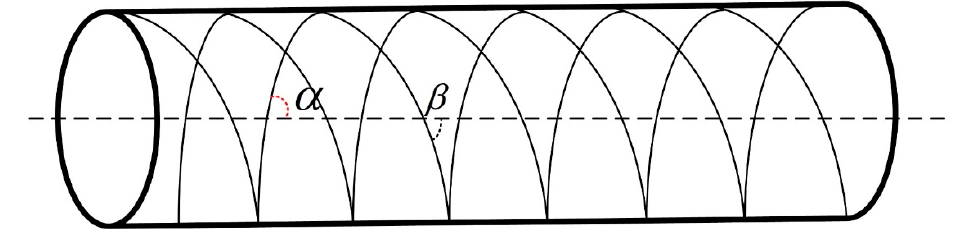
tion and radial elongation, respectively, and gles of the fiber, as shown in Figure 2. fiber, as shown in Figure 2. δ is the net angular deformation of the actuator’s end. l 0 l and r are the initial actuator lengths. and r 0 are the initial actuator lengths. l ∗ , r ∗ are the deformed elemental axial length end. 0 0 and radius, respectively. length and radius, respectively.